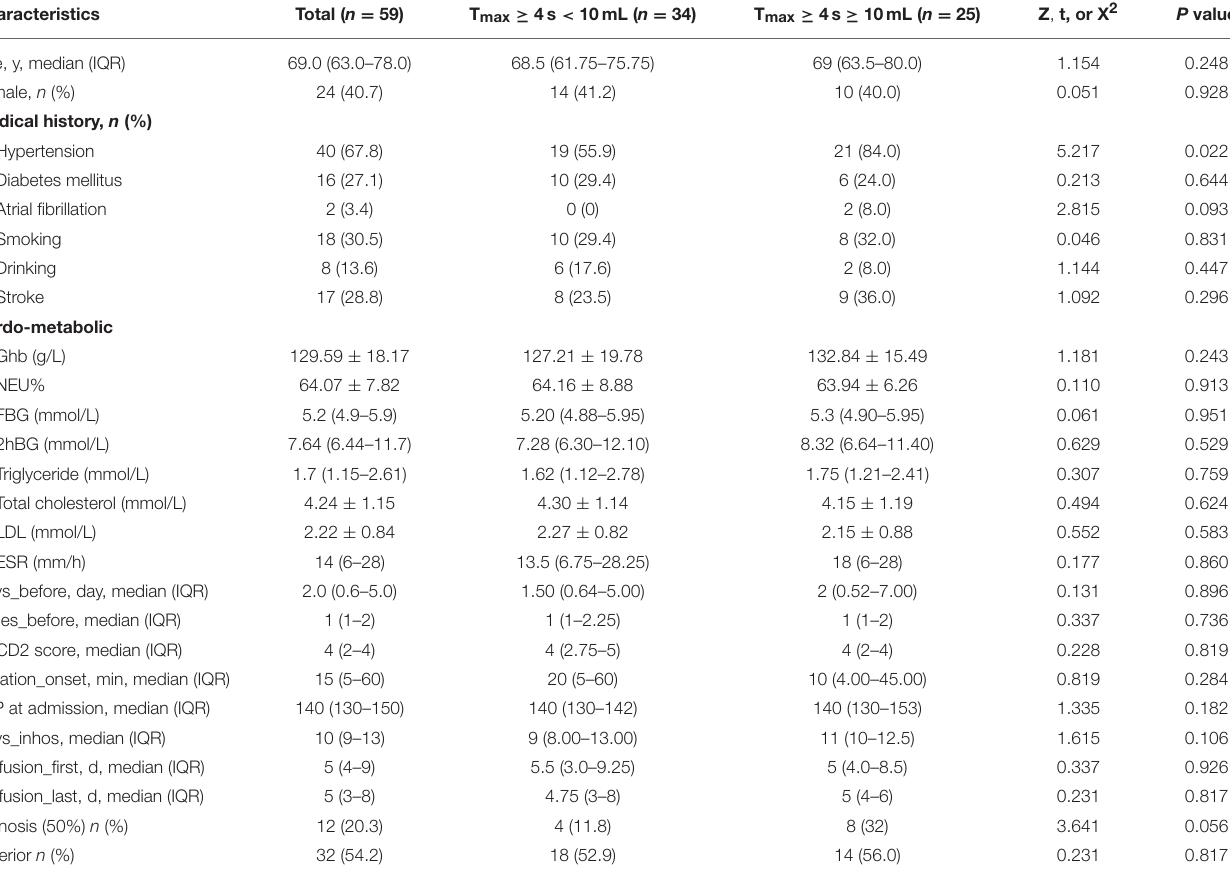
TABLE 1 | Basic demographic and clinical characteristics of TIA patients ( n = 59) stratified according to the presence of MR perfusion abnormality. Characteristics